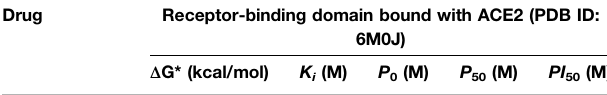
TABLE 3 | Results of the amount of free protein assuming a competitive inhibition of the RBD-ACE2 complex in the presence of the NSAIDs bound to the